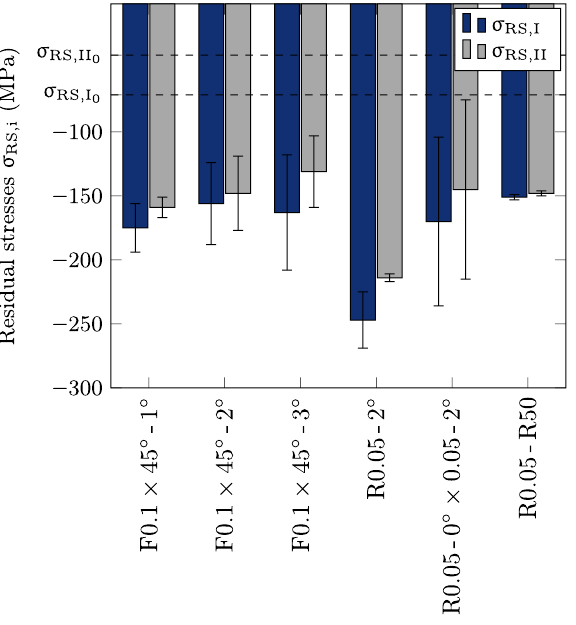
Figure 7. Residual stress state of the generated surfaces depending on tool cutting edge angle, corner geometry, and minor cutting edge geometry ( v c = 250m/min, f z = 0.015mm, a p = 0.25mm, a e =